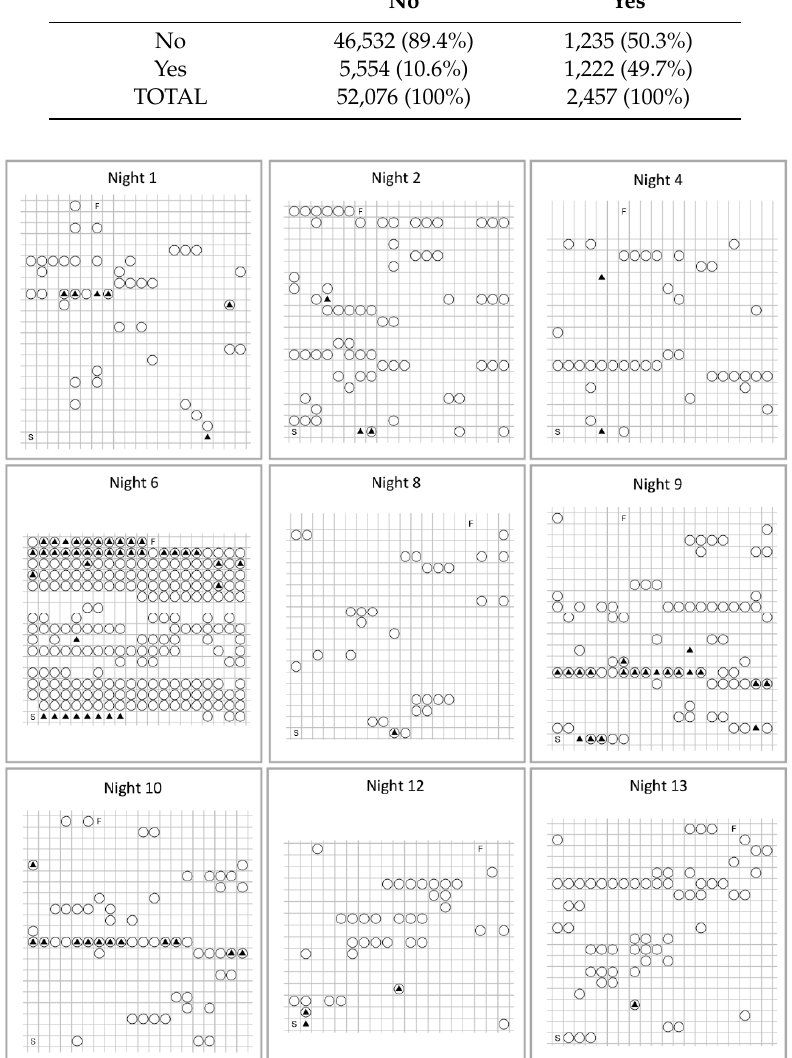
Figure 2. The movement states for one human-dog dyad across a selection of sleep periods (nights). These illustrations reflect a variety of movement patterns by dog and human when co-sleeping. For example, dog and human sleeping together with little movement (night 8); bouts of high level of dog movement with little human movement (nights 2, 4, 12, 13); and, high levels of dog and human movement (nights 6, 9). Each cell represents a 1-minute epoch, and should be read from bottom left of matrix to top right. Beginning of period indicated by S (start) and completion of sleep period indicated by F (finish). ▢ = no human or dog movement; ▲ = human movement only; ◯ = dog movement only; ◯▲ = both human and dog movement.